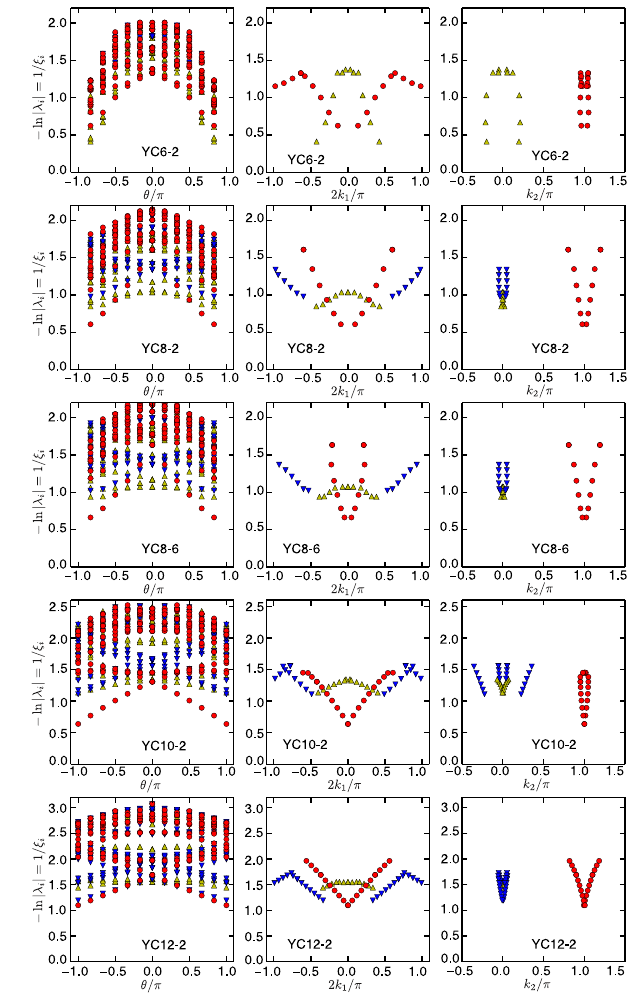
FIG. 11. The S z ¼ 1 transfer matrix spectrum of J 2 ¼ 0 . 1 for the YC6-2, YC8-2, YC8-6, YC10-2, and YC12-2 cylinders. Here, the bond dimension is m ¼ 6000 .